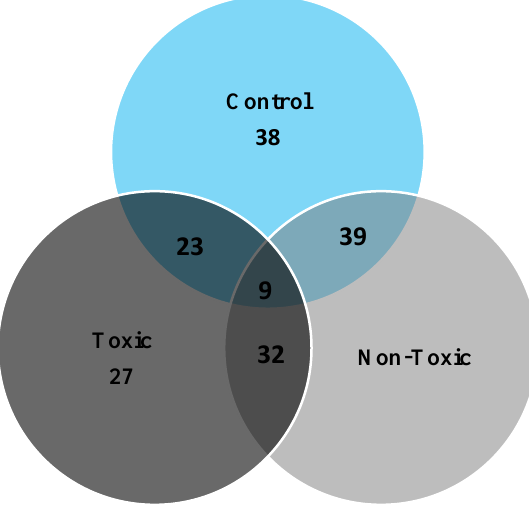
Figure 4. Venn graphical representation of no.of spots in the control, non-toxic and toxic dose rats